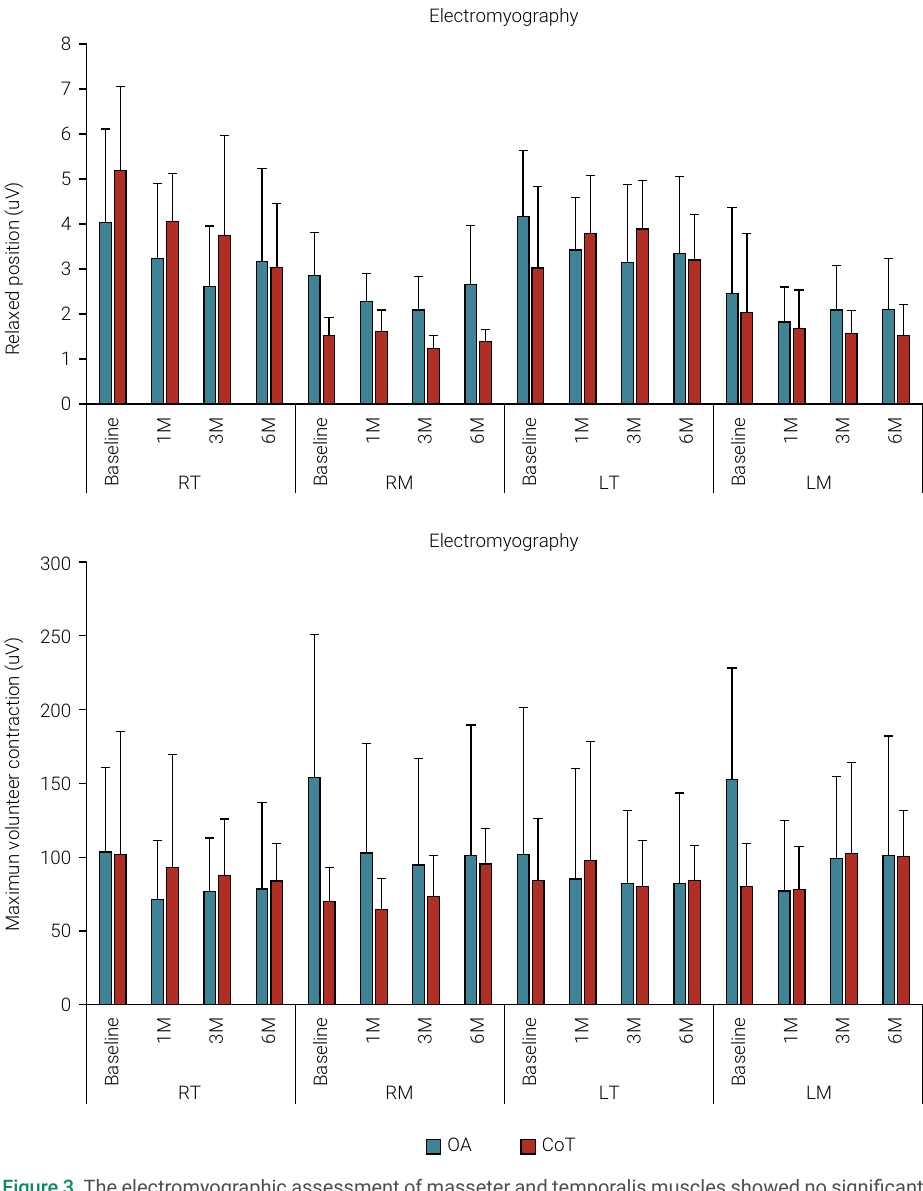
Figure 3. The electromyographic assessment of masseter and temporalis muscles showed no significant differences within groups (p>0.05; one-way repeated measures ANOVA followed by Tukey´s multiple comparisons test). Among groups comparisons also showed no differences (p>0.05; three-way repeated measures ANOVA followed by Tukey´s multiple comparisons test) neither on (A) relaxed muscular